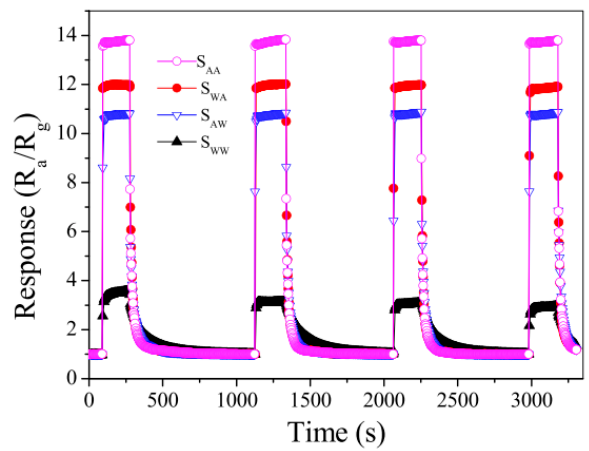
Figure 13. Responses to 50 ppm acetone gas for S AA , S WA , S AW and S WW at 250 °C [54].